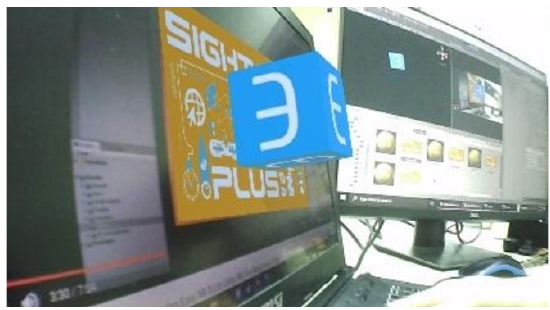
Figure 3 : Marker based Augmented Reality